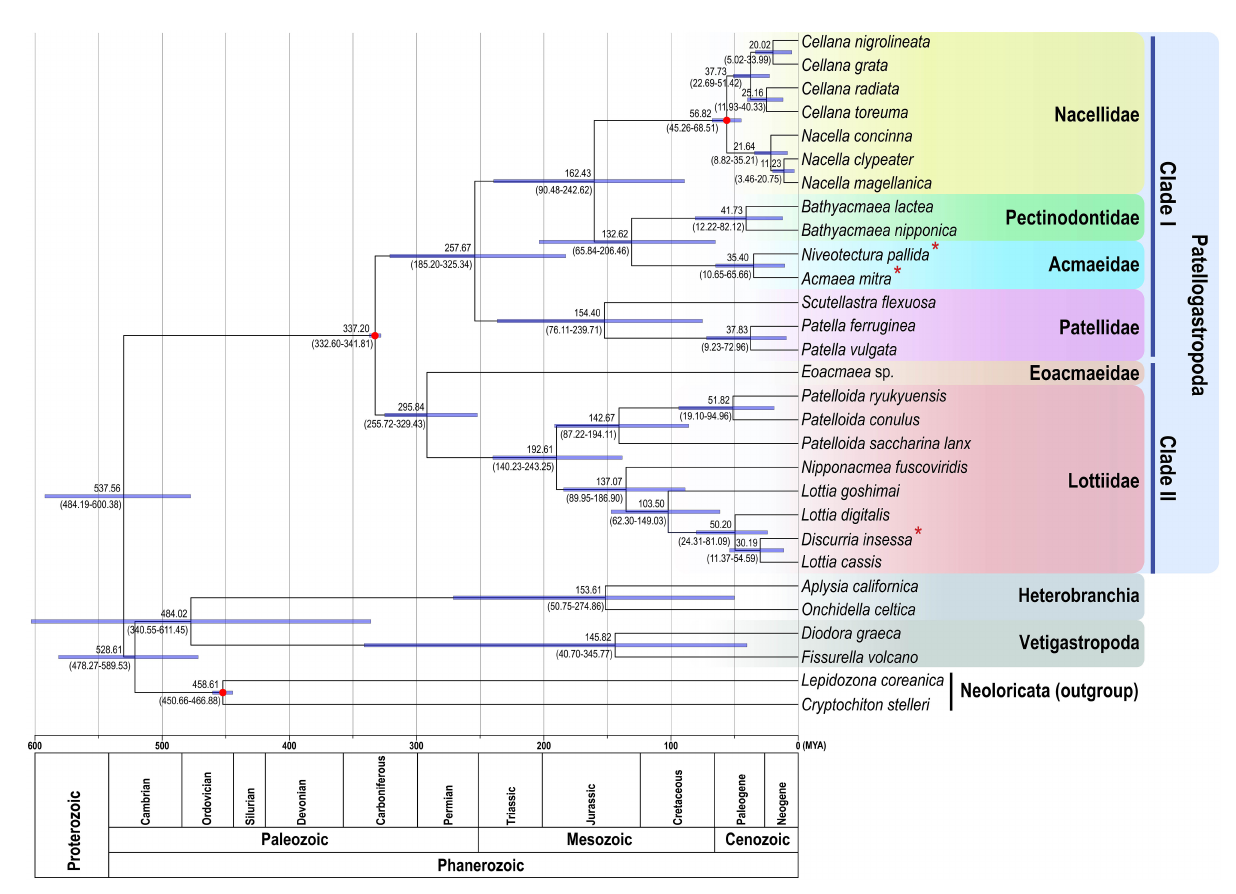
FIGURE 3 Time-calibrated phylogenetic chronogram showing the mean age estimates (with 95% HPD intervals) based on 13 protein coding genes of patellogastropod mitochondrial genomes. Newly determined mtDNA sequences in this study are marked with an asterisk (*), and calibration constraints are represented by red dots on the corresponding